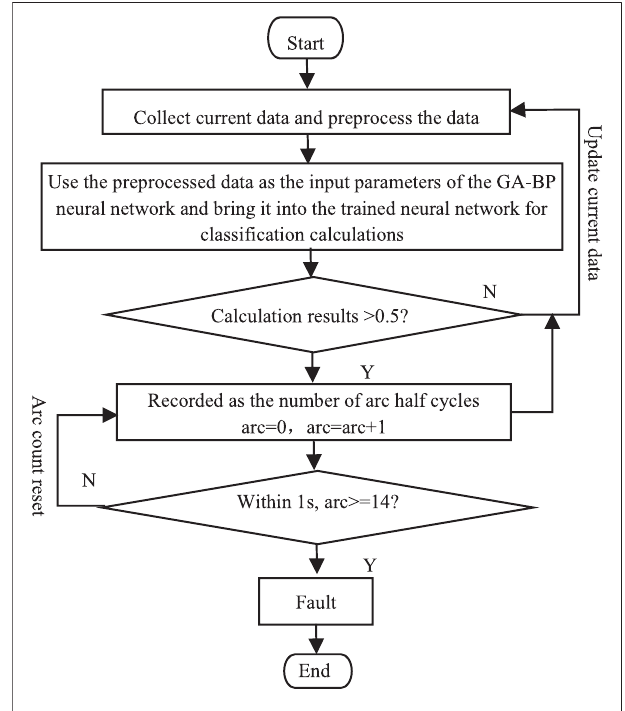
FIGURE 16 | GA-BP algorithm fl ow